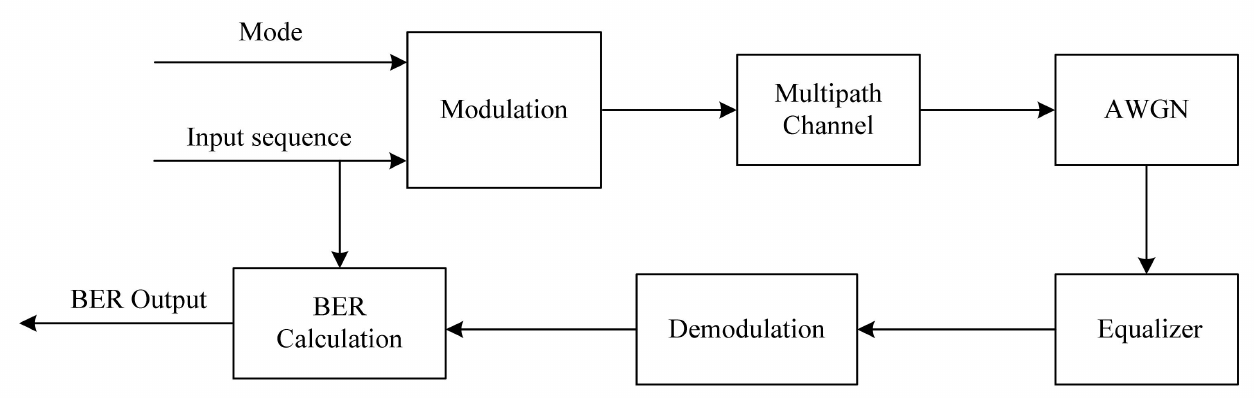
Figure 1. Simplified diagram of the VM system.